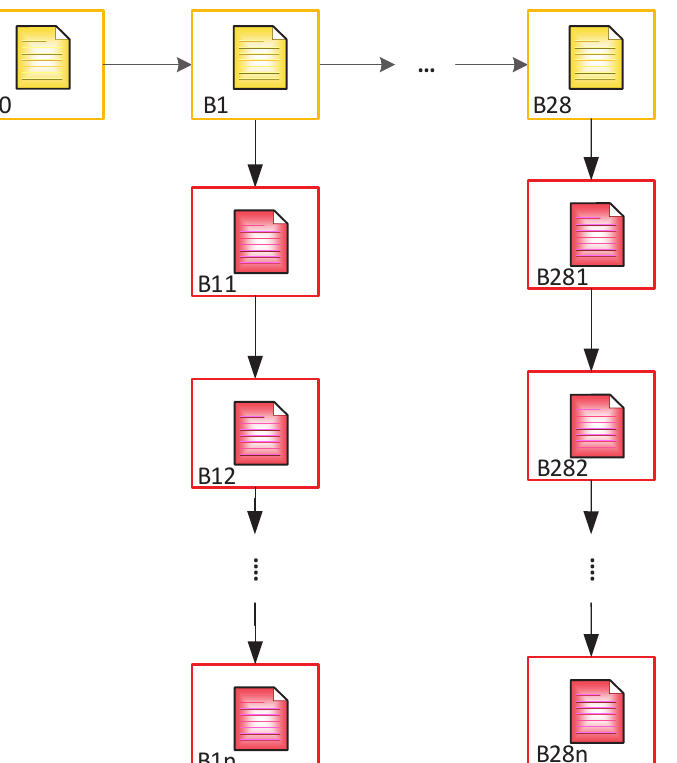
Figure 7. Two-level tree Blockchain for the EU